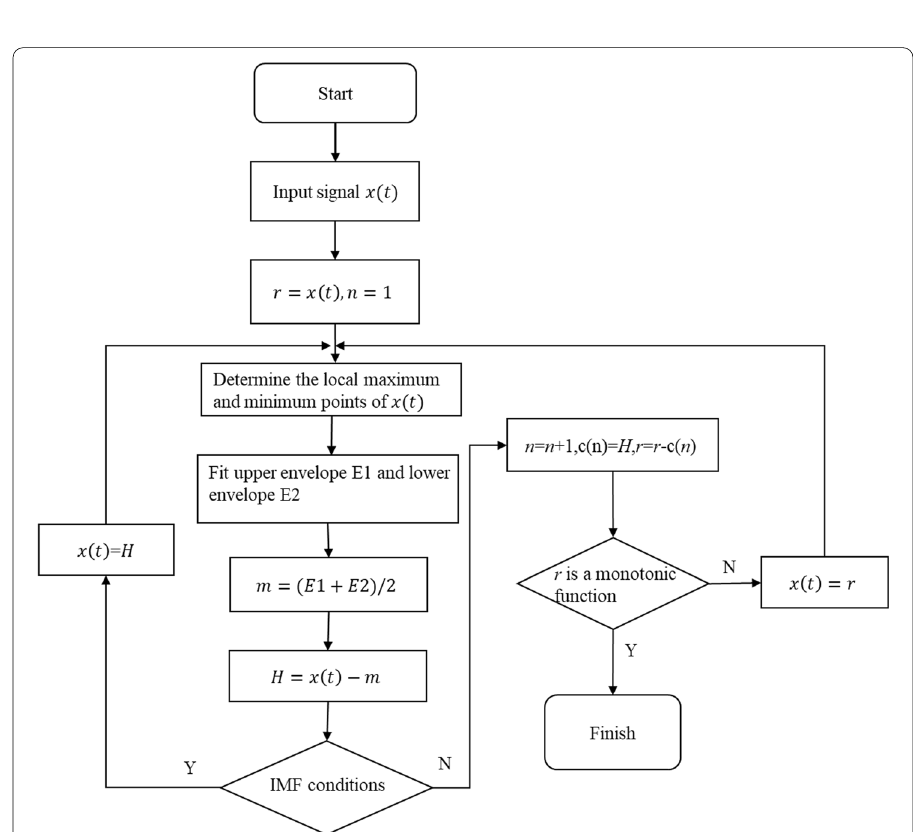
Fig. 4 Flowchart of